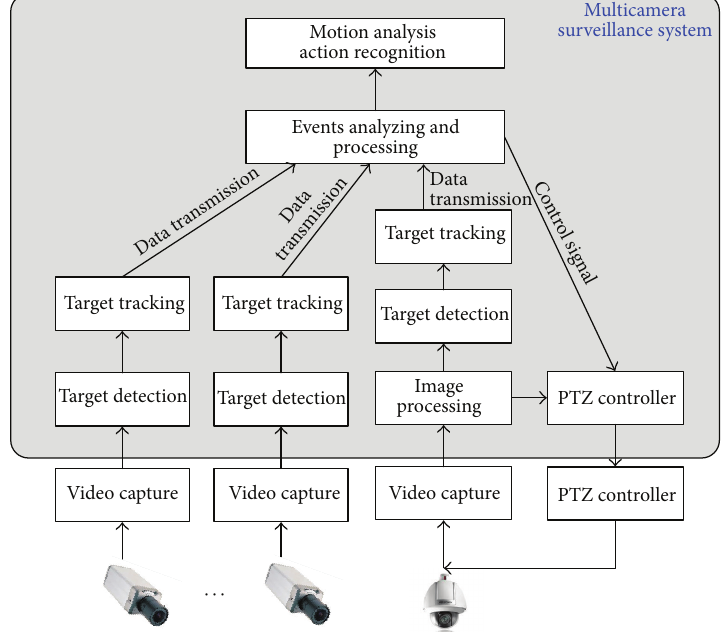
Figure 1: The structure diagram of IVSS with a multicamera